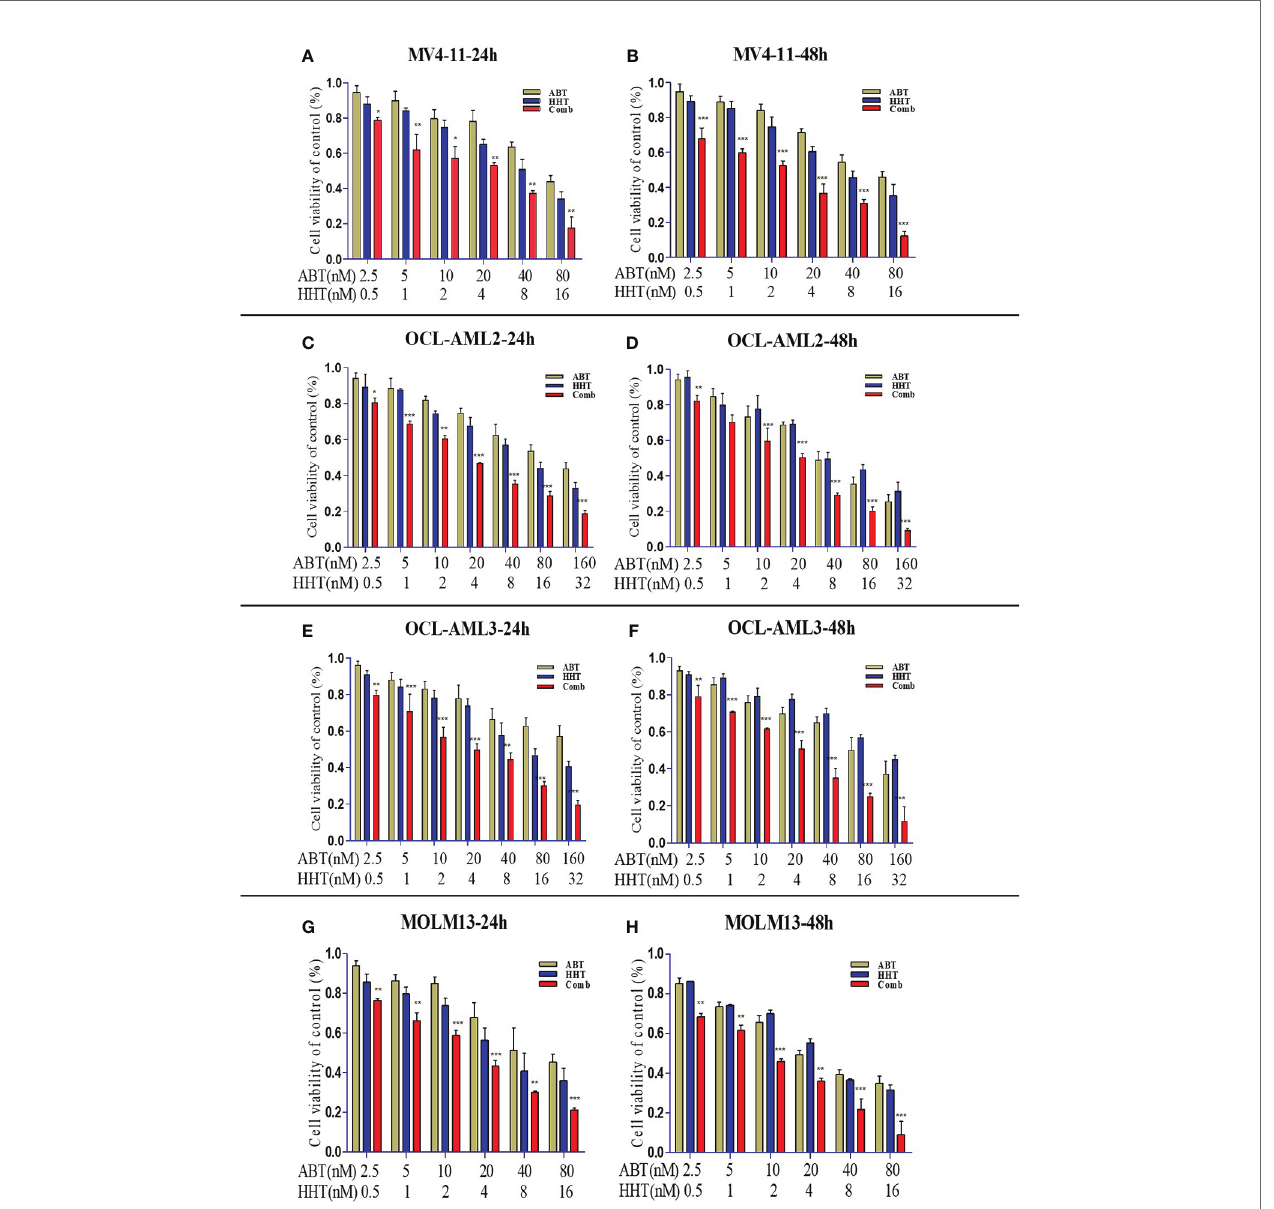
FIGURE 1 | AML cell lines (OCL-AML2, OCL-AML3, MOLM13, and MV4-11) were treated with various doses of ABT-199 or HHT alone or in combination for 24 h or 48 h (A – H) . The percent viability is normalized to the percent viability of the DMSO-treated control. Values are expressed as the mean ± S.D. @ of three independent experiments (*P < 0.05, **P < 0.01, and ***P <